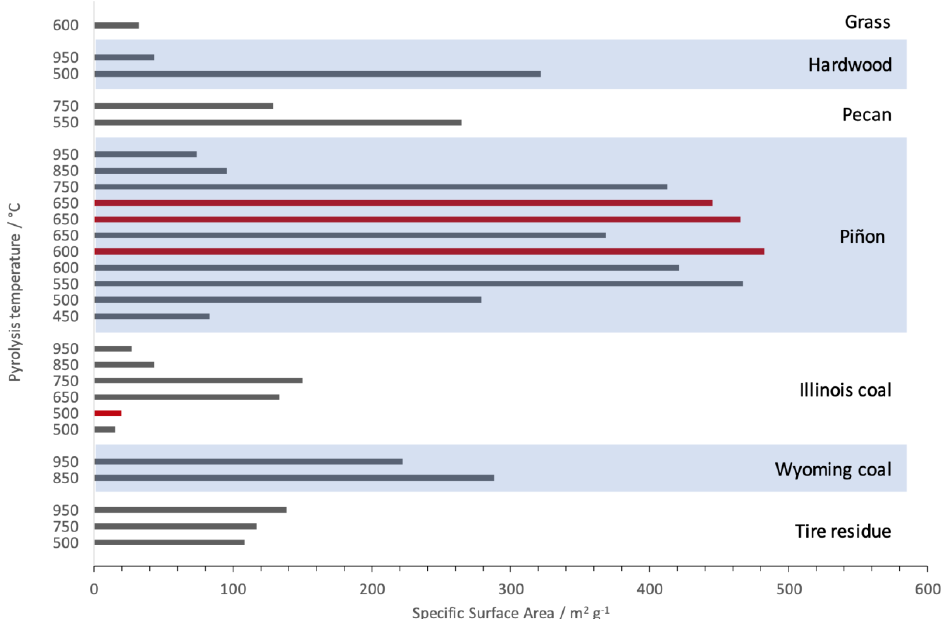
Figure 7. Summary of surface area data for samples prepared in the tube furnace at the indicated pyrolysis temperatures under flowing nitrogen (grey bars) or flowing 0.11% (vol.) oxygen in nitrogen (red bars). All data are normalized to the mass of the activated carbon analyzed. A comparison of SSA values for pairs of samples prepared at the same pyrolysis temperature, but under varying oxygen concentrations shows a significant boost when 0.11% (vol.) oxygen was used compared to when no oxygen was added to the gas stream.